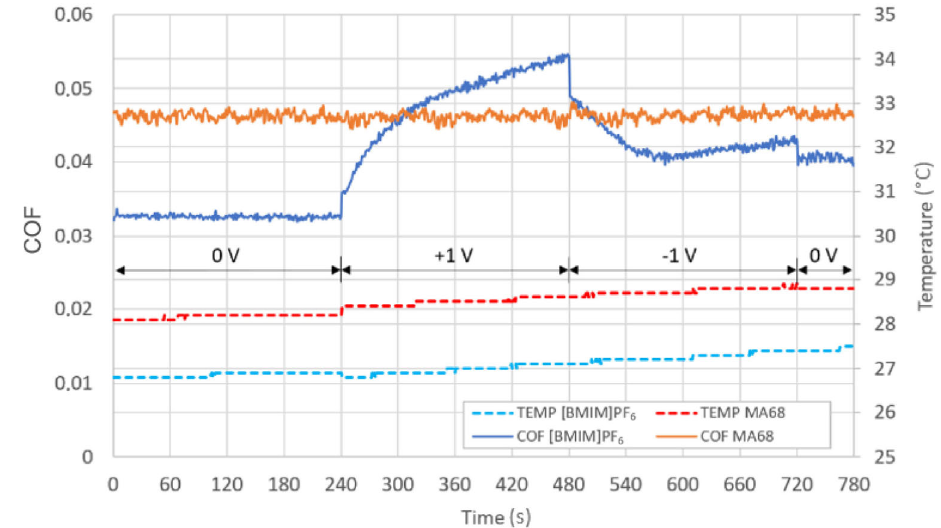
Fig. 10 MA68 and [BMIM]PF 6 COF and temperature dependence on